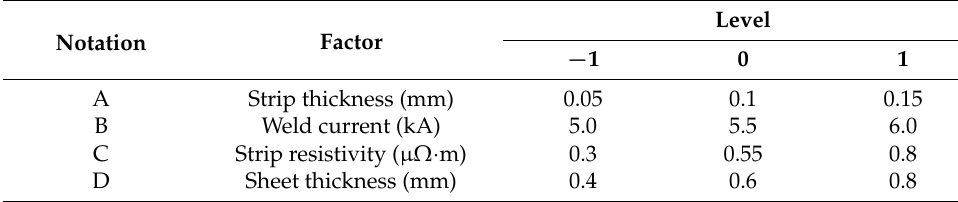
Table 2. Factors and the design levels.